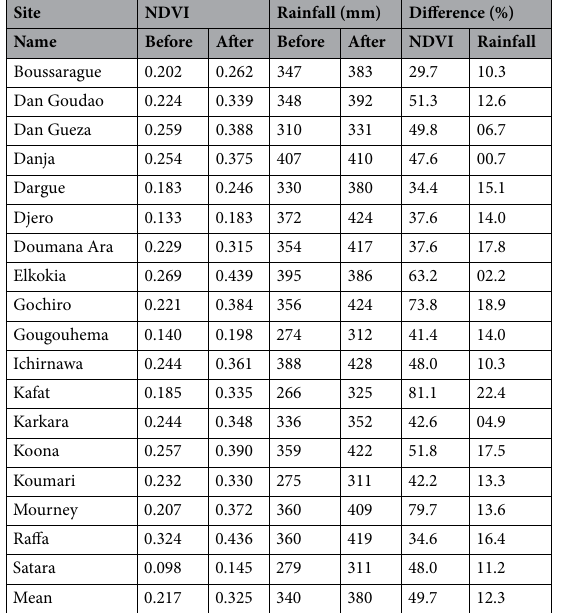
Table 1. Summary of mean annual peak NDVI values (Aug–Oct) before and after intervention with the mean total rainfall (Jun–Aug) from 2010 to 2020.